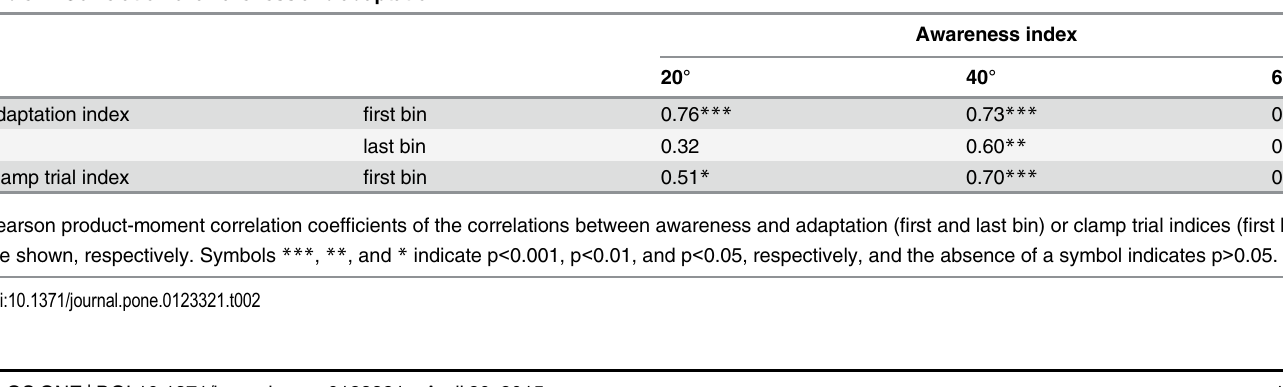
Table 2. Correlation of awareness and adaptation.